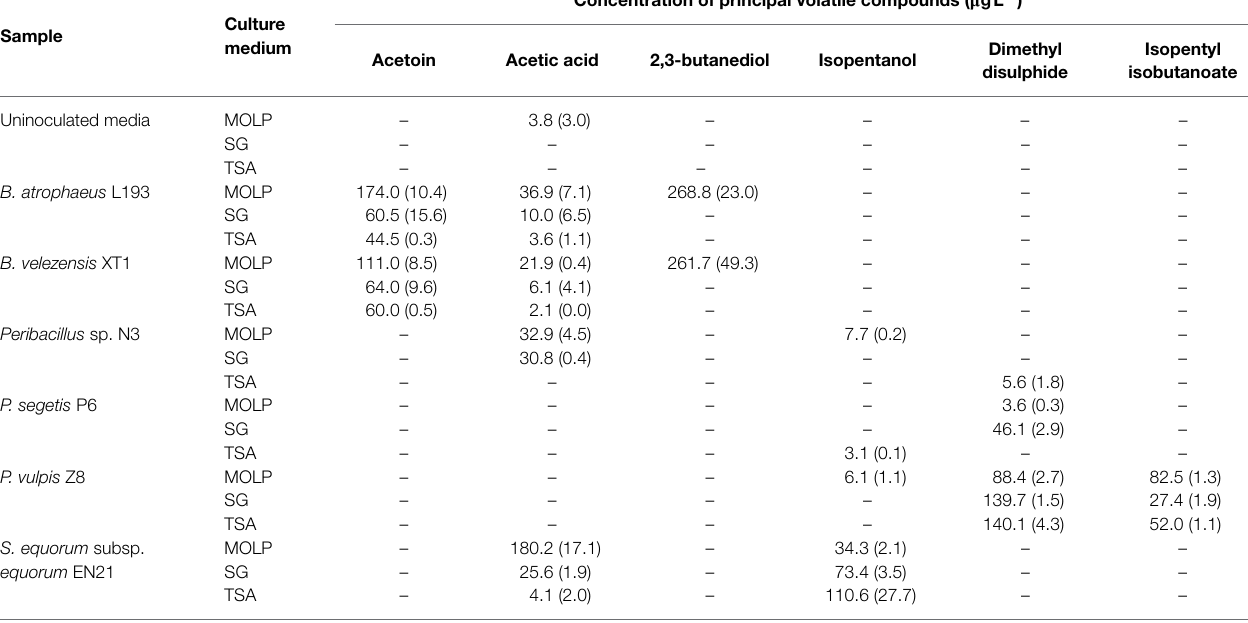
TABLE 1 | Principal volatile compounds for each strain after culturing in MOLP, SG and TSB media.